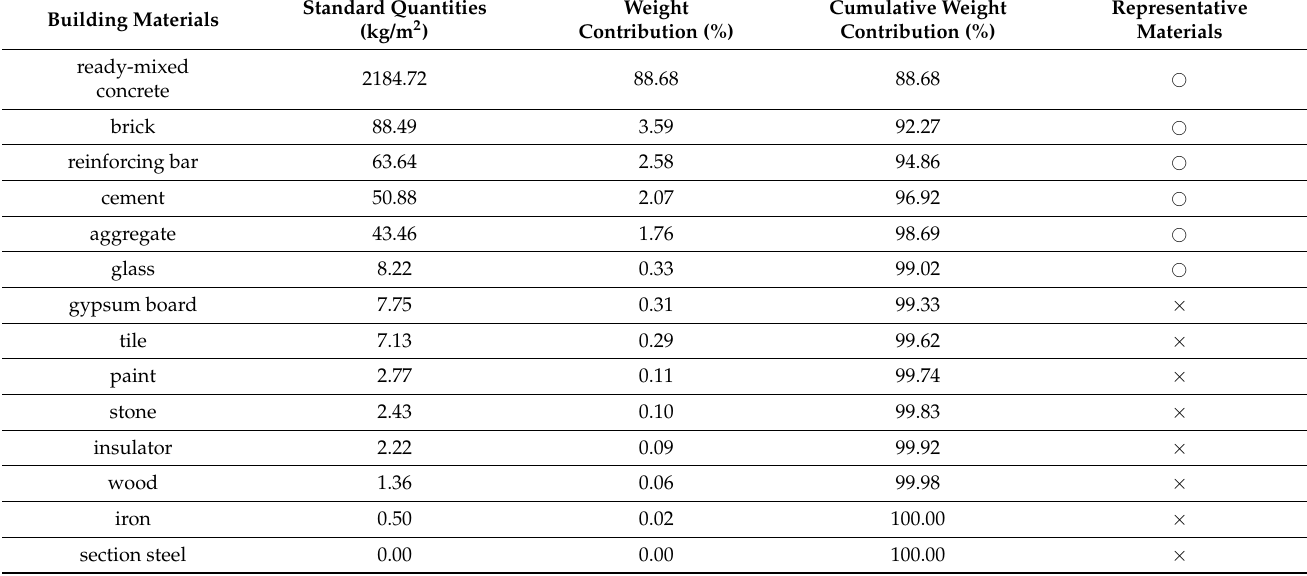
Table 4. Apartment building material standard quantity database.